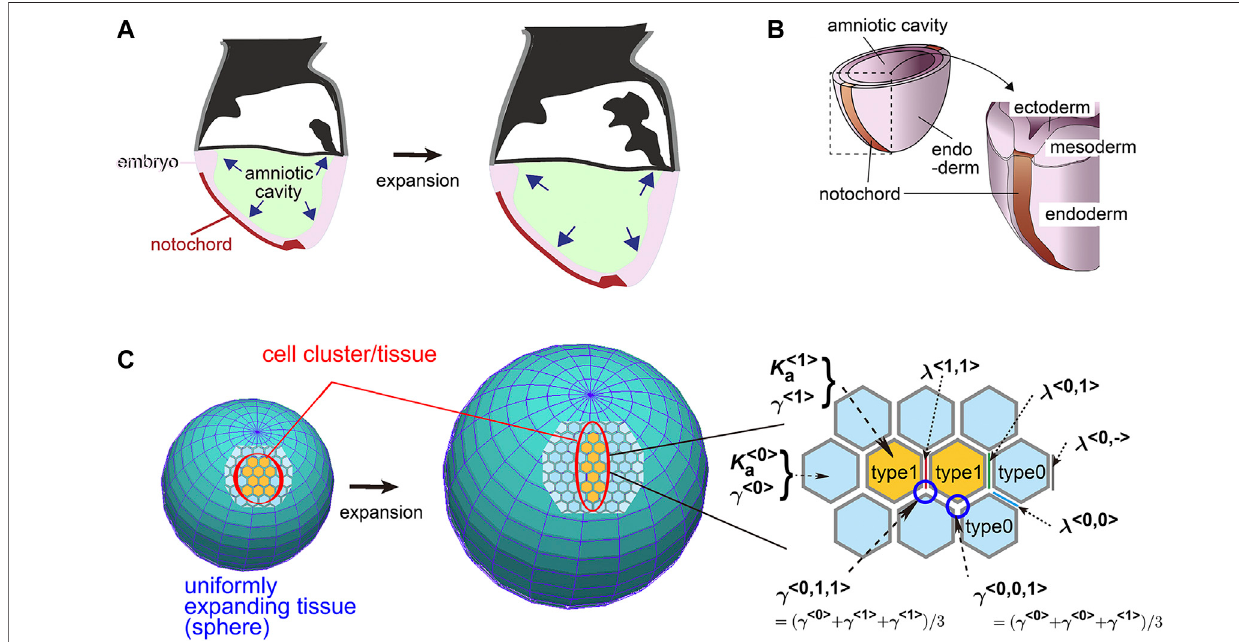
FIGURE 1 | Mouse notochord, uniformly expanding fi eld, and vertex model. (A) Cross – sectional illustration of a mouse embryo is shown. The amniotic cavity pushes the embryo on the surface of which the notochord is located. (B) Three – dimensional illustration of a mouse embryo with the notochord, the cell layers, and the cavity is shown. (C) A theoretical framework of a uniformly expanding fi eld and vertex model is described. In the left panel, on a uniformly expanding tissue (two spheres before and after expansion), a cell cluster (orange) with its surrounding cells (light blue) is located. In the right panel, the vertex model is described where the area elasticities, the friction coef fi cients, and the line tensions are shown. The type 1 cells, orange; the type 0 cells, light blue. The panels A and B are originated from our previous study with permission (Imuta et al., 2014).